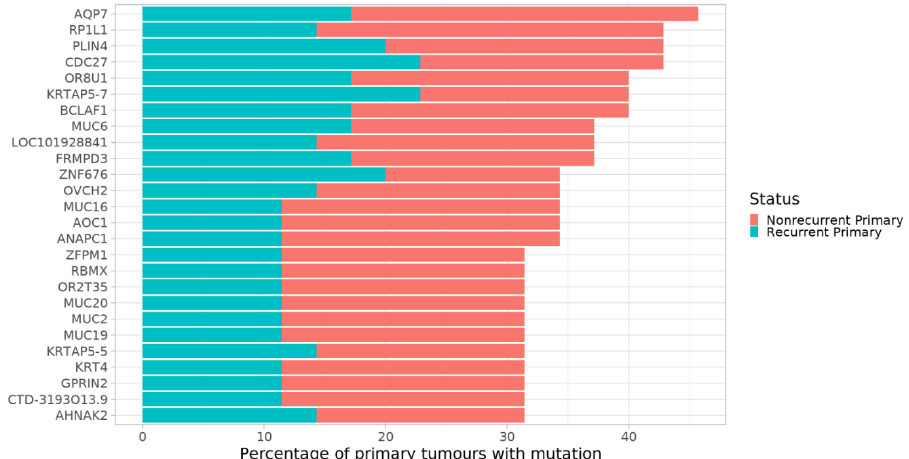
Figure 3. Bar plot of all genes mutated in >30% of primary tumours. Genes are on the y -axis. The x - axis shows the percentage of all primary tumours where a gene is mutated. Colour indicates recurrent or nonrecurrent status.